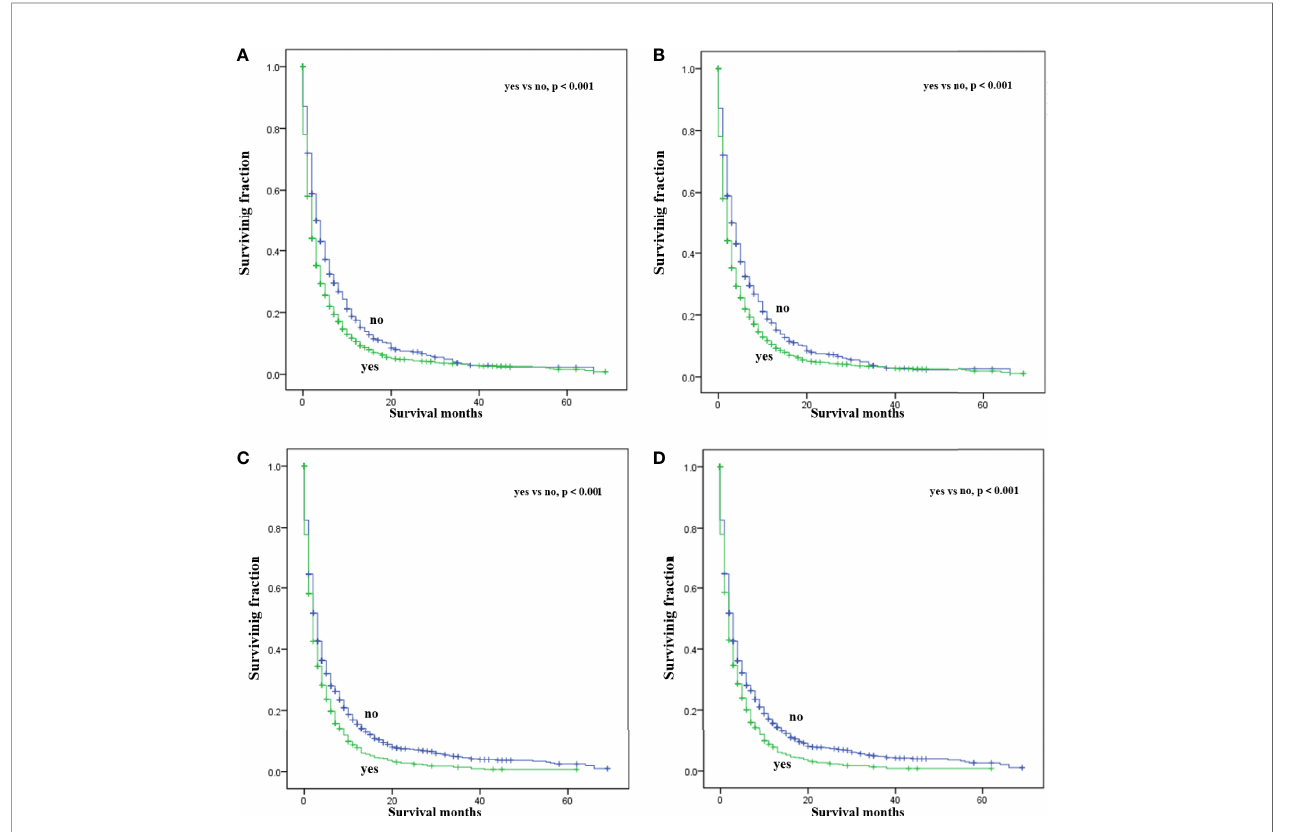
FIGURE 6 | Kaplan-Meier survival curves for estimating OS and CSS in patients with PCBM based on liver (A, B) and lung (C, D) metastasis.